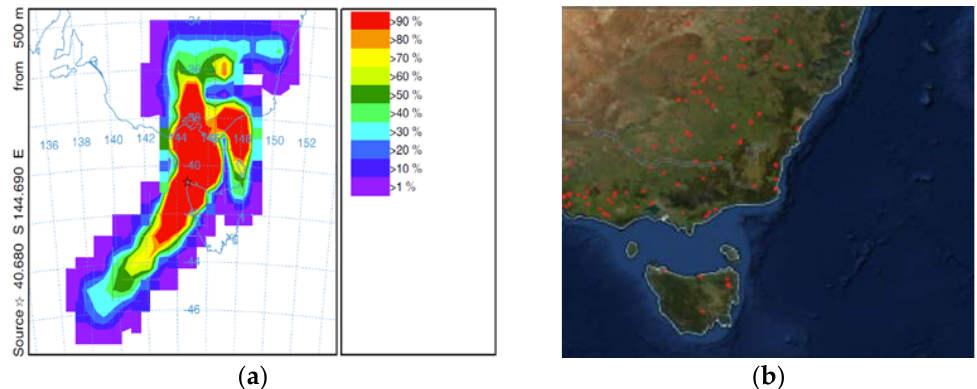
Figure 11. ( a ) 48 h backward trajectory frequency (500 m) arriving at Cape Grim site on 25 June 2019. The back trajectories were calculated using NOAA HYSPLIT 4.8 model. ( b ) The fire spots are from level 2 Terra/MODIS thermal anomalies/fire product (MOD14).